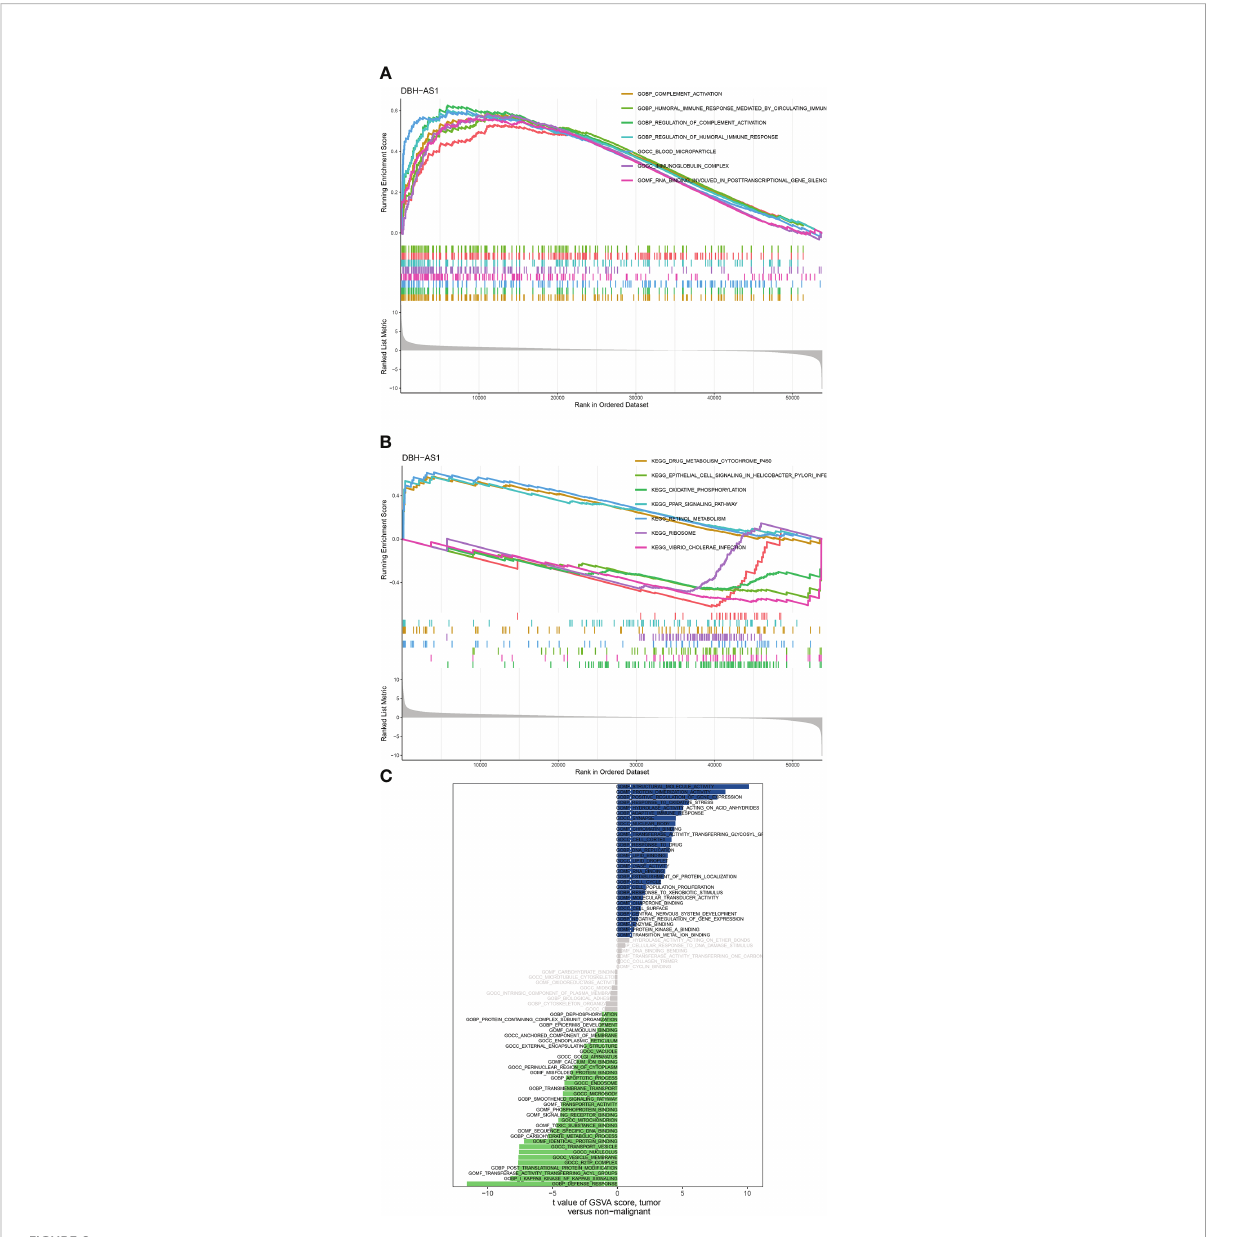
FIGURE 8 (A, B) GSEA analysis between DBH-AS1 high- and low-expression groups. (C) GSVA analysis between DBH-AS1 high- and low-expression